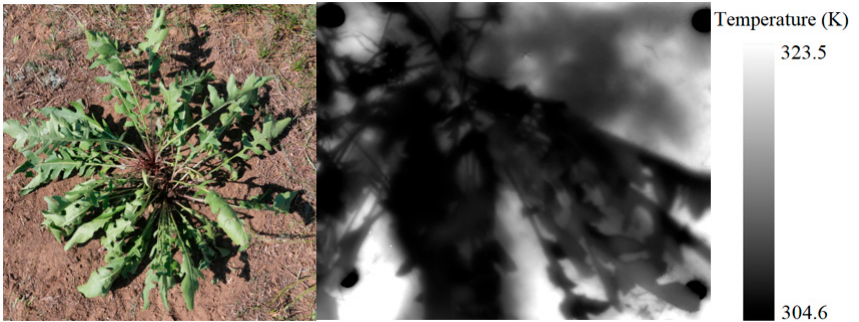
Figure 19. Temperature of Cichorium intybus .